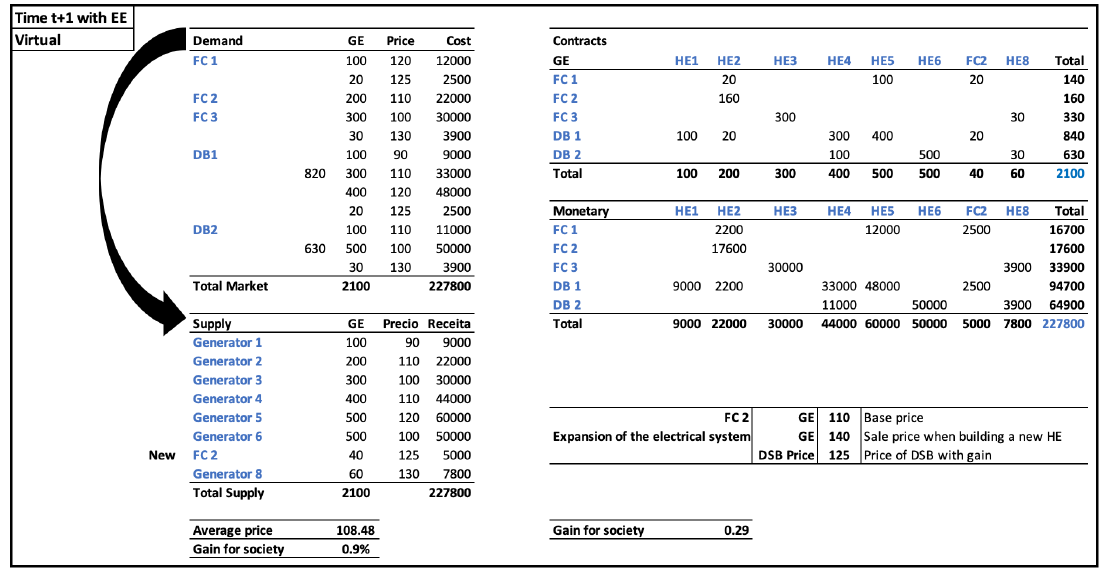
Figure 6. Results of the